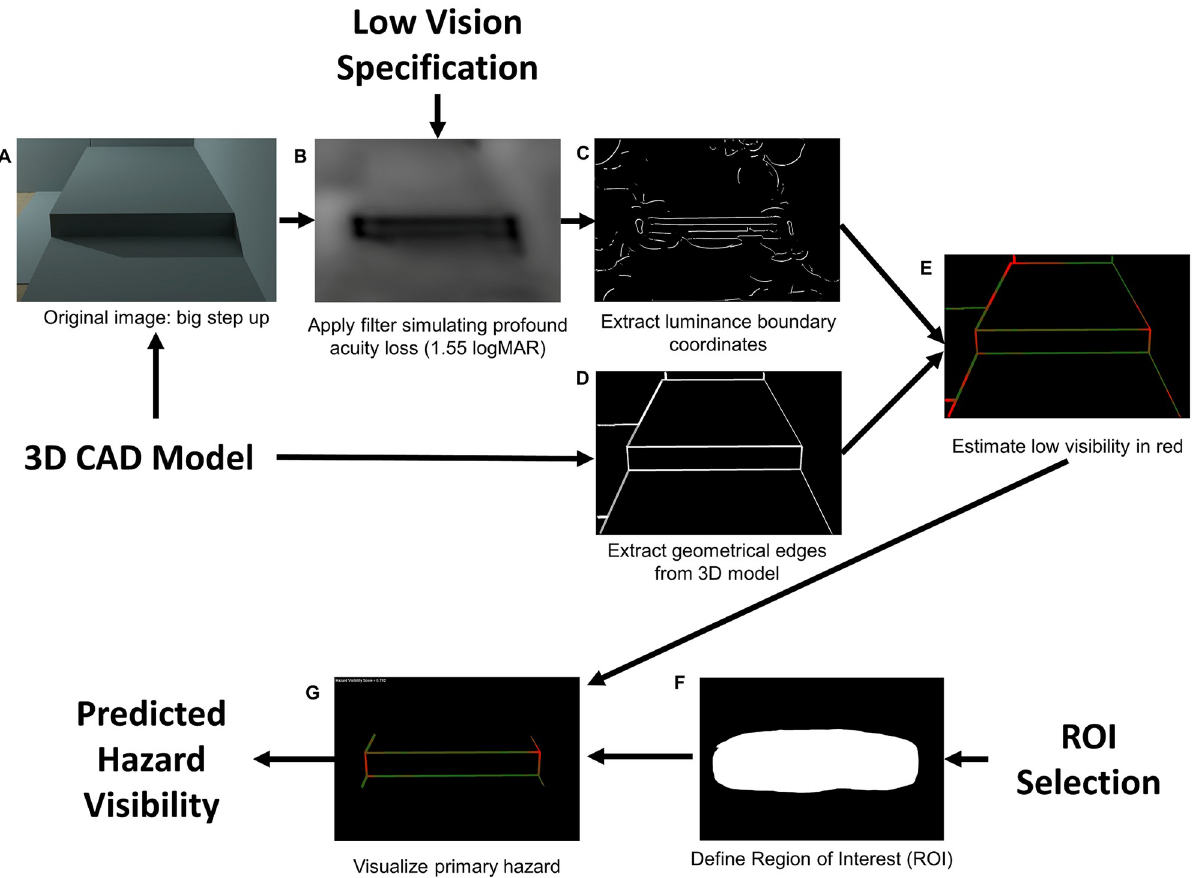
Fig 1. Workflow of the DeVAS software. A: the original image of a step rendered by Radiance software. B: image filtered to simulate Severe low vision (VA 1.55 logMAR, CS 0.6 Pelli-Robson). C: luminance boundaries extracted from the filtered image. D: Pixels representing Geometric edges inferred from 3D data map of the space. E: Estimation of hazard visibility, based on a match between the luminance contours in C and the geometrical edges in D. Color coding represents the closeness of the match, ranging from red (poor match) to green (good match). F: A manually defined Region of Interest (ROI), G: The conjunction of E and F which specifies the hazard region of primary focus, which is used to generate the final Hazard Visibility Score (HVS).